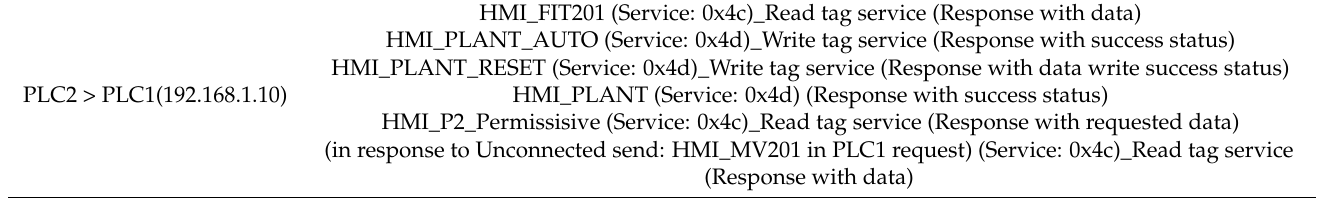
Table A2. PLC2 Communications in SWaT.